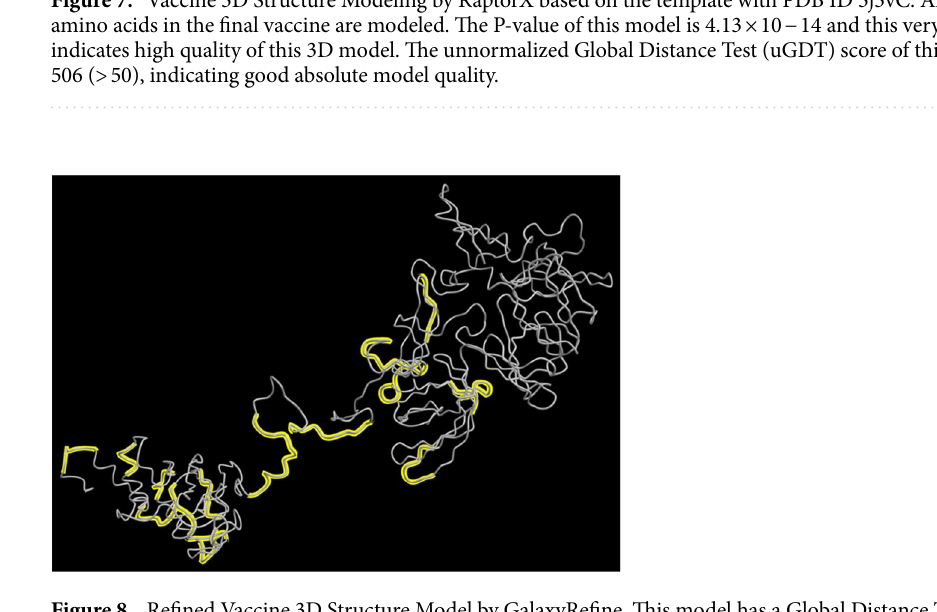
Figure 8. Refined Vaccine 3D Structure Model by GalaxyRefine. This model has a Global Distance Test—High Accuracy (GDT-HA) score of 0.900, a Root Mean Square Deviation (RMSD) score of 0.580, a MolProbity score of 2.618, a clash score of 33.5 and a Ramachandran plot score of 87.5%, showing great overall model quality. The B-cell epitopes in this final vaccine 3D model are highlighted in yellow.